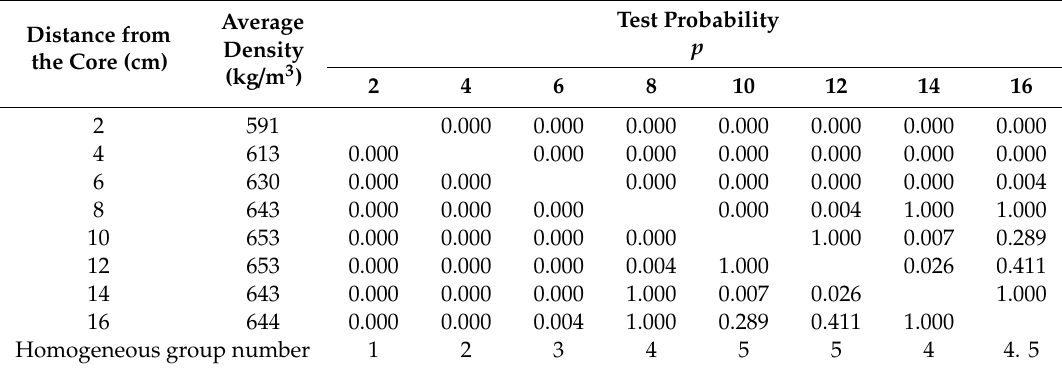
Table 7. Tukey test of the factor “distance from the core” for the distribution of average densities over the cross-section of the entire birch